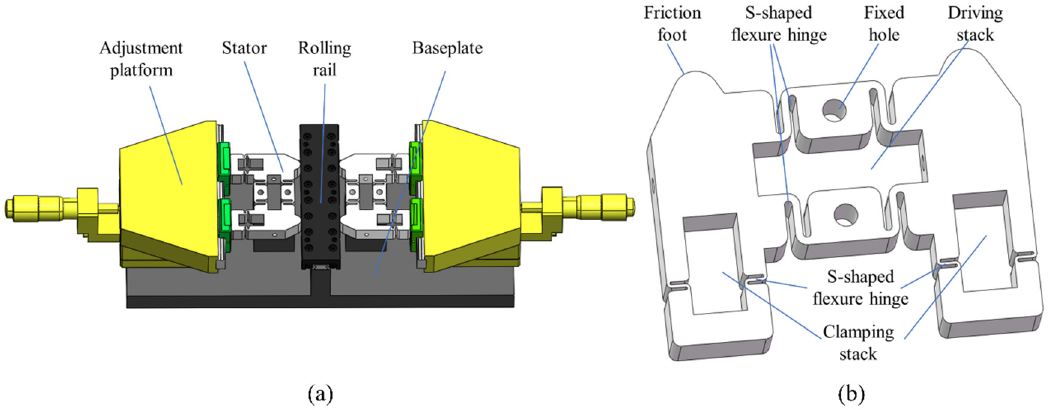
Figure 2. The stepping piezoelectric actuator: ( a ) assembly of construction; ( b ) stator.